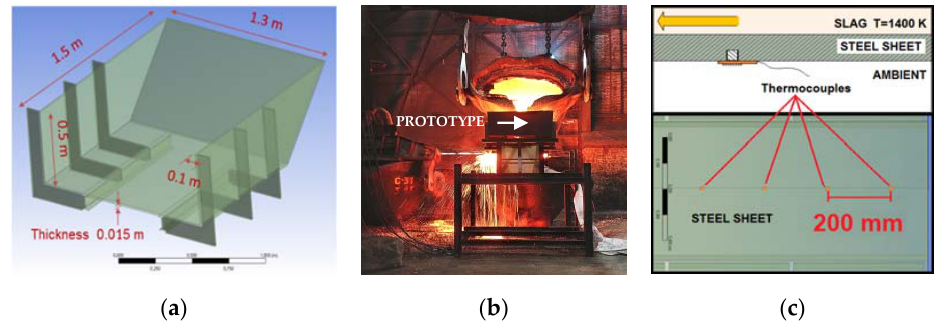
Figure 6. Layout of the prototype and the experiment. ( a ) Prototype main dimensions; ( b ) prototype during the test; ( c ) location of the thermocouples.